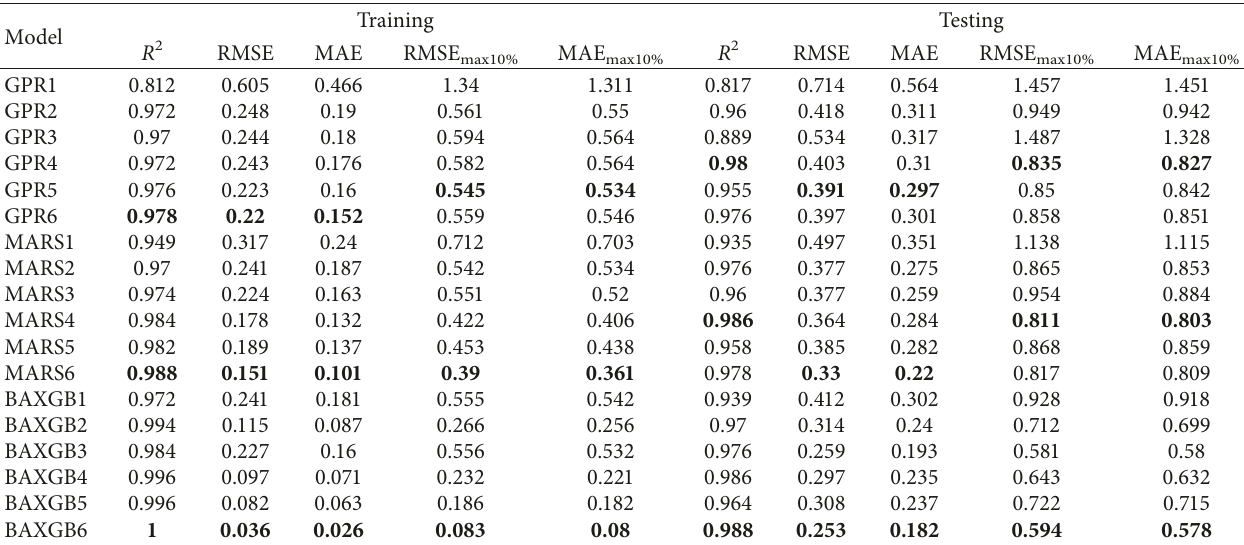
Table 6: Results of the statistical indicators for all models in the Taiyuan station during the training and testing stages.